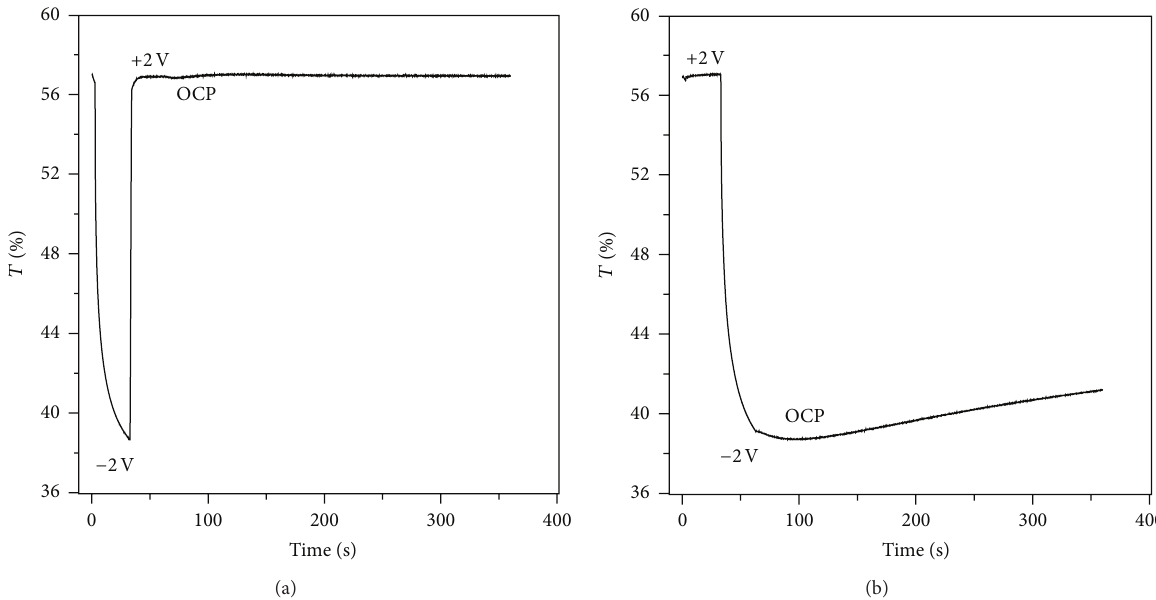
Figure 14: Time stability UV-VIS Transmittance measurements at open circuit and fixed wavelength (700nm) for a WO 3 /PE/V 2 O 5 ECD. Electrodes configuration:WO 3 /ITO/Glass as cathode and V 2 O 5 /ITO/PET as anode. (a) bleached state ( 𝐸 = +2 V versus V 2 O 5 for 10s); (b) coloured state ( 𝐸 = −2 V versus V 2 O 5 for